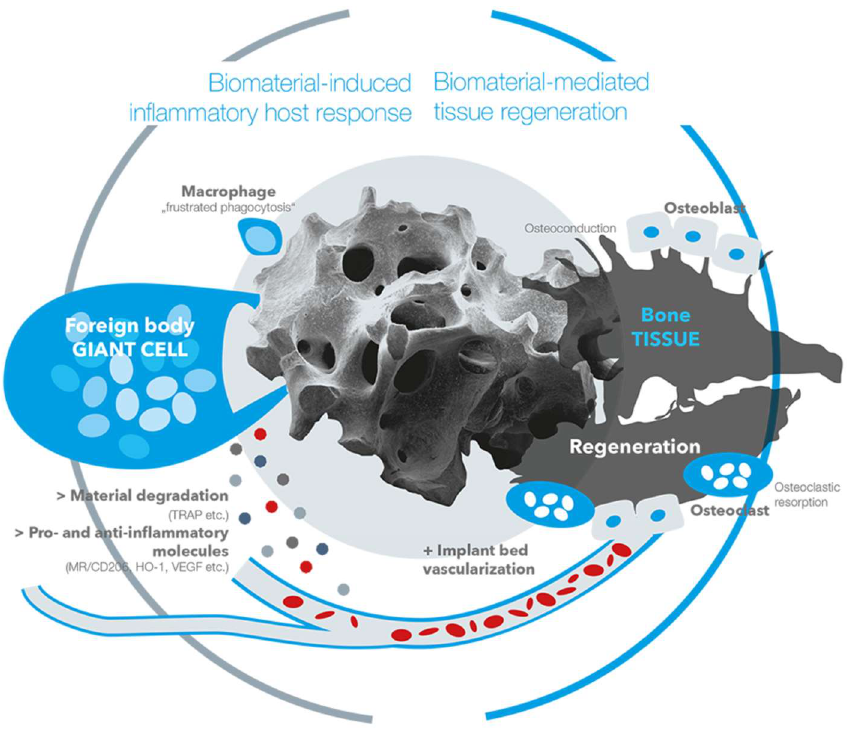
Figure 9. Theoretical pathways between the biomaterial-induced inflammatory host response and the material-mediated tissue regeneration.